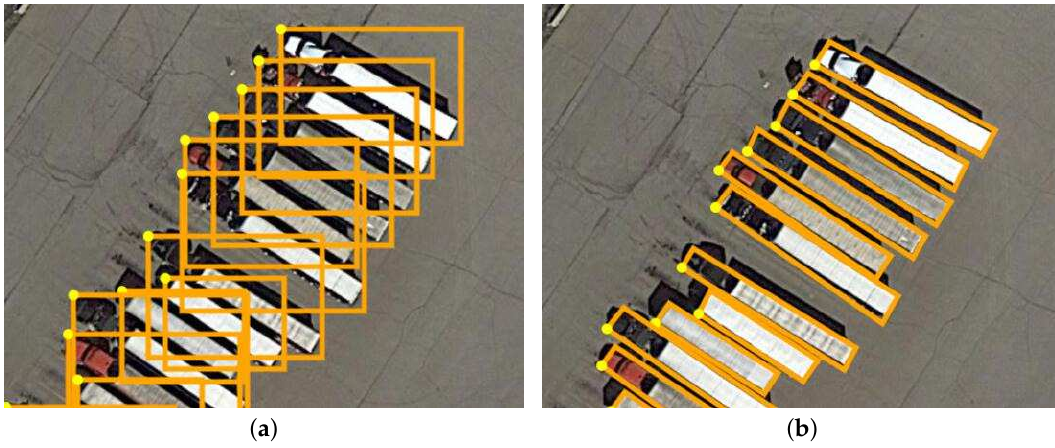
Figure 1. A group of large vehicles with different annotation methods: ( a ) shows a failure case of horizontal rectangle annotation, which leads to high overlap, compared to ( b